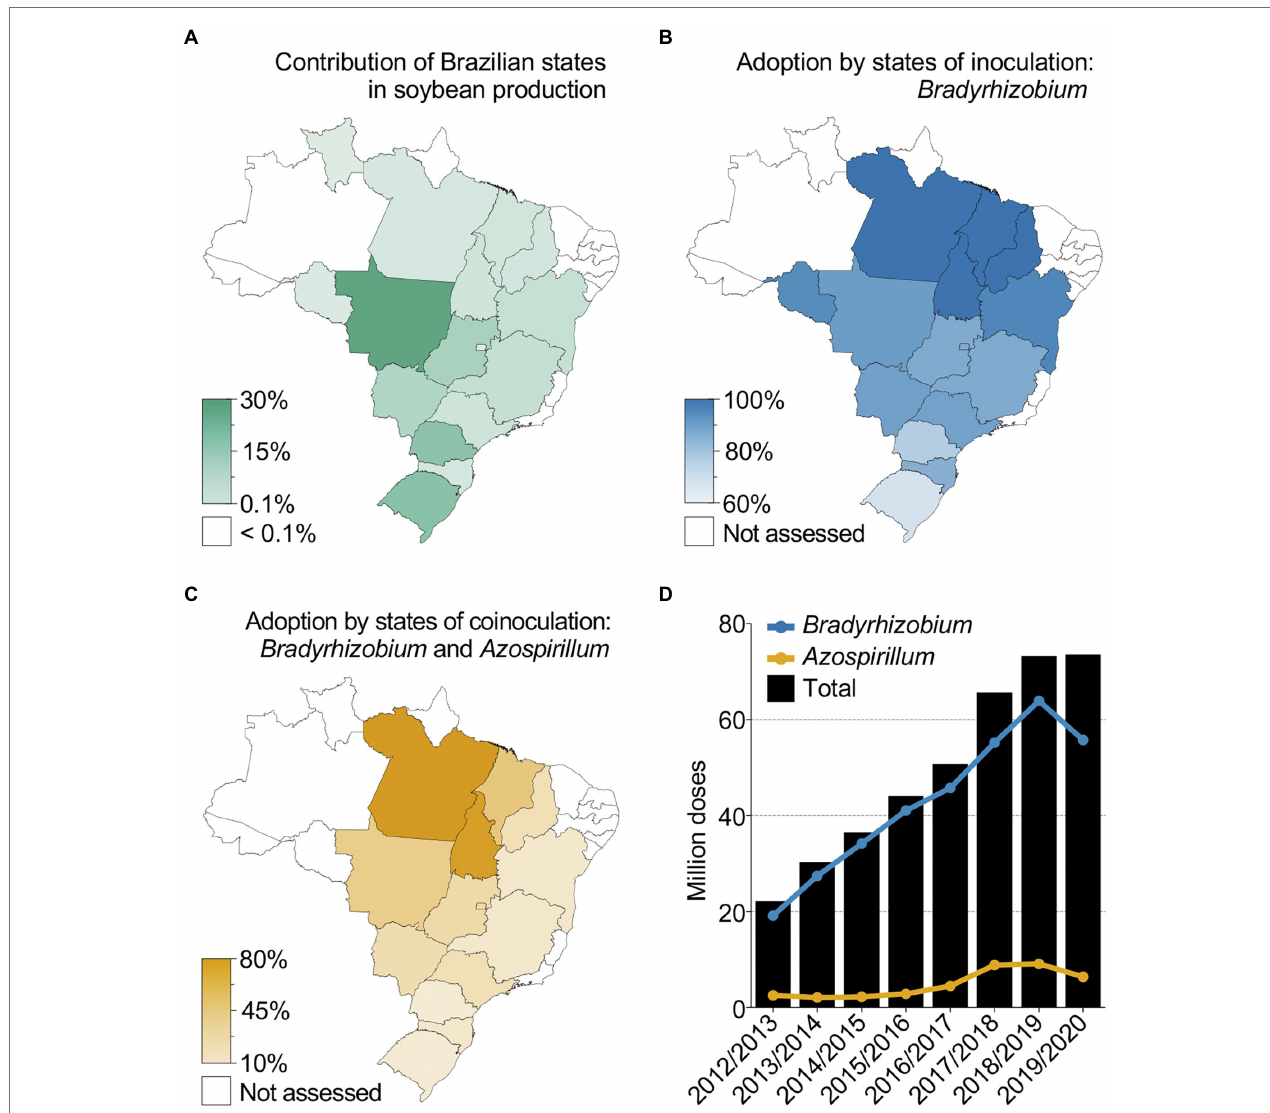
FIGURE 2 | Soybean microbial inoculation and co-inoculation in Brazil. (A–C) Individual state contributions to soybean production (A) , adoption by states (% of area) of Bradyrhizobium -based inoculants (B) and adoption by states (% of area) of Azospirillum -based inoculants (C) for co-inoculation in Brazil in the 2019/2020 soybean crop season. (D) Total number of inoculant doses for BNF, Bradyrhizobium -based inoculant applied to soybean and Azospirillum -based inoculant for grasses, sold in Brazil over several years. A partial number of doses are shown in the 2019/2020 crop season due to incomplete data collection (Source: ANPII/ Spark). Data from the 2019/2020 crop season were based on 3,551 interviewed farmers covering an extrapolated soybean planted area of 98% with a 95% confidence level and a 1.6% margin of